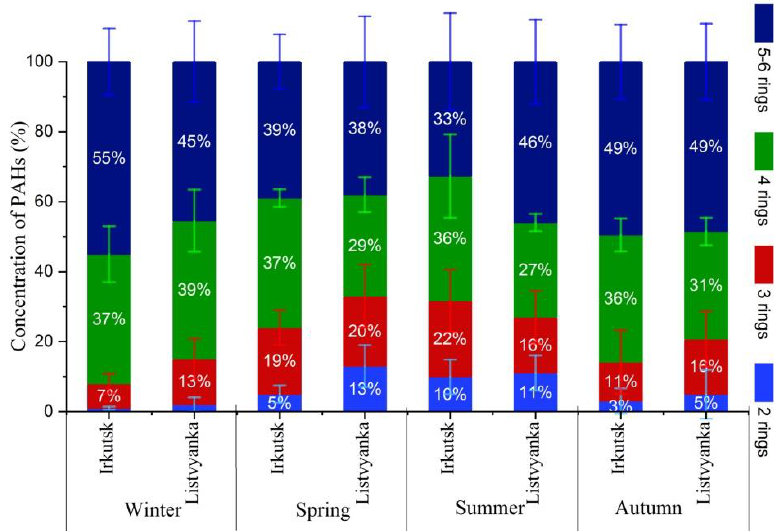
Figure 4. Average percentage of individual PAHs (± standard deviation) in aerosols at stations Ir- kutsk and Listvyanka (Southern Baikal region) from 2015 to 2021.